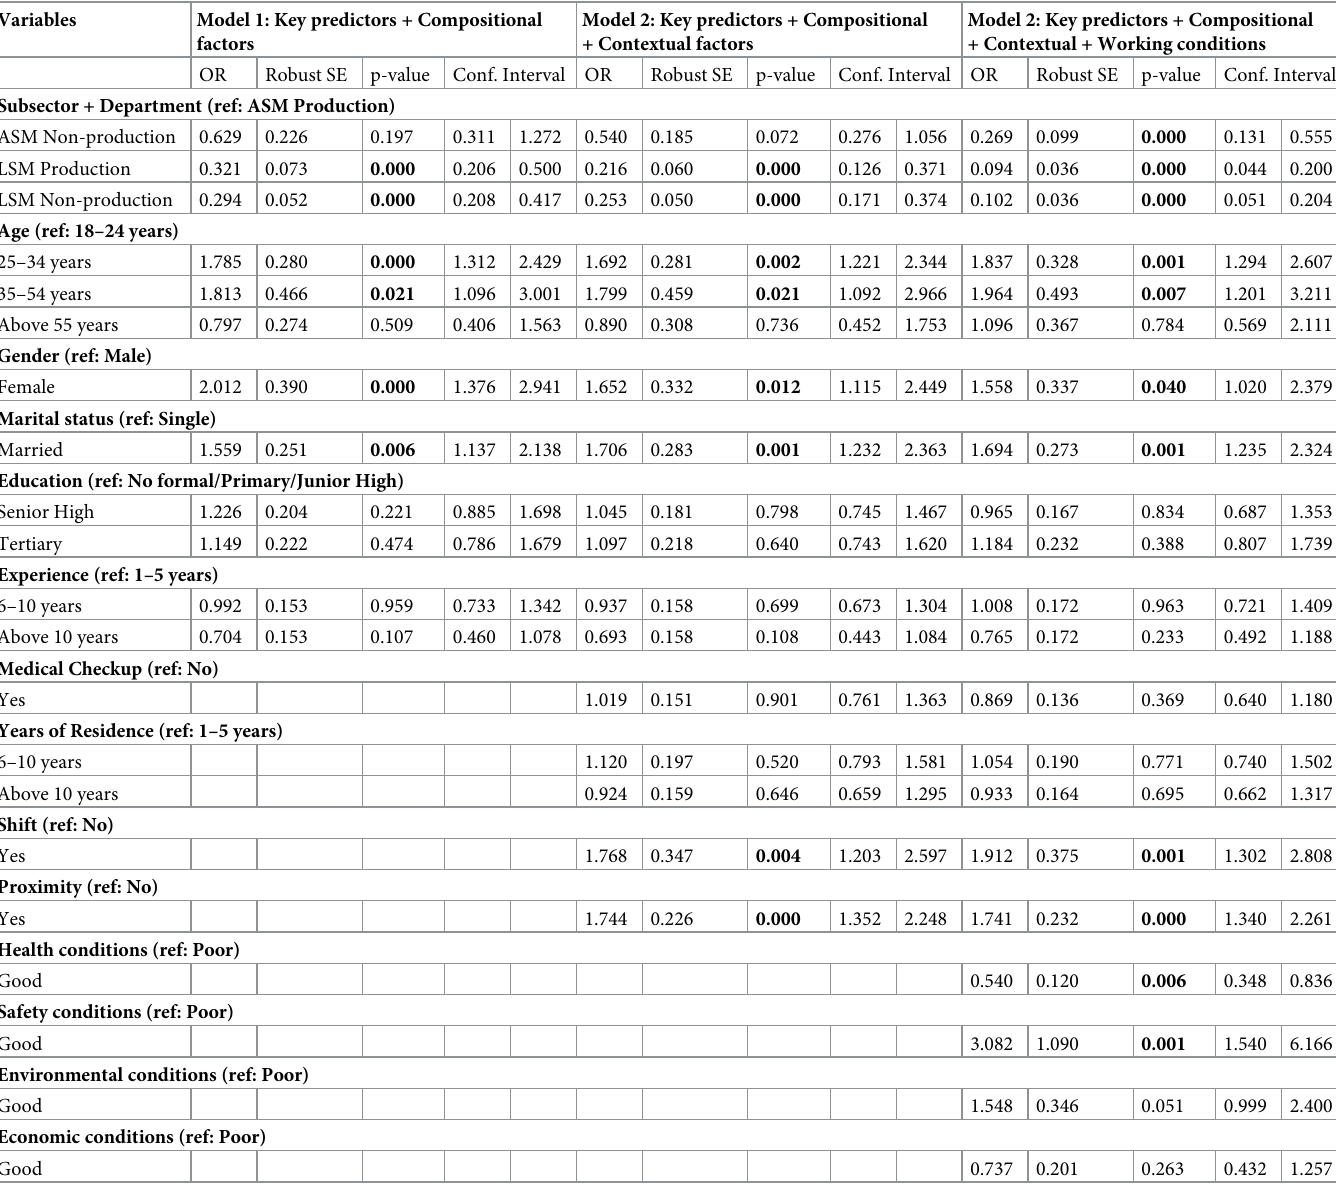
Table 3. Multivariate negative log-log regression model predicting experiencing occupational related health problems by gold mine